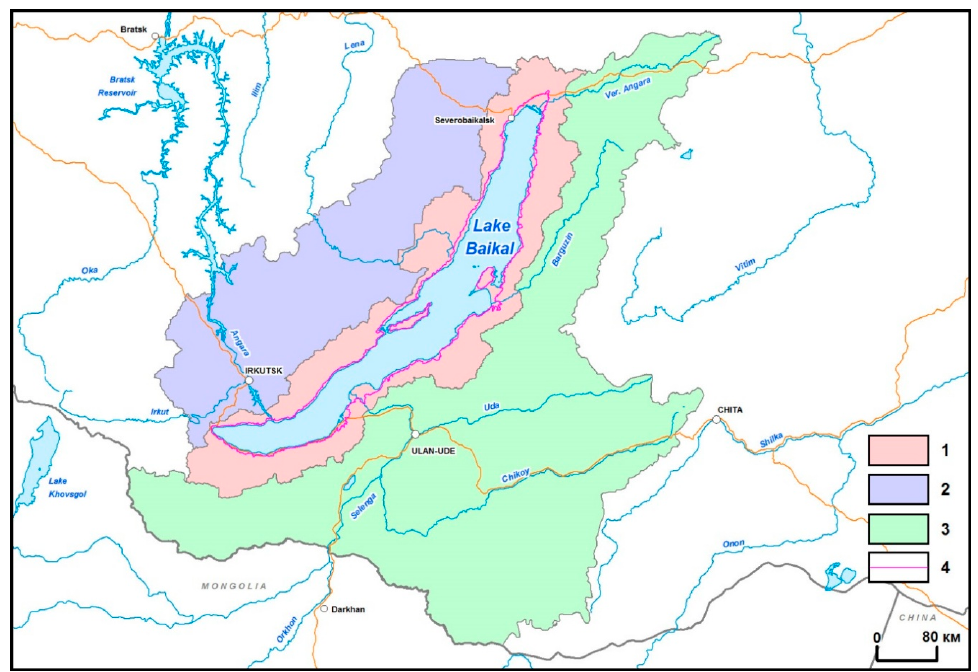
Figure 1. Baikal Natural Territory. 1—central ecological zone; 2—ecological zone of atmospheric influence; 3—buffer ecological zone; 4—water protection zone (WPZ) of Lake Baikal (2018).